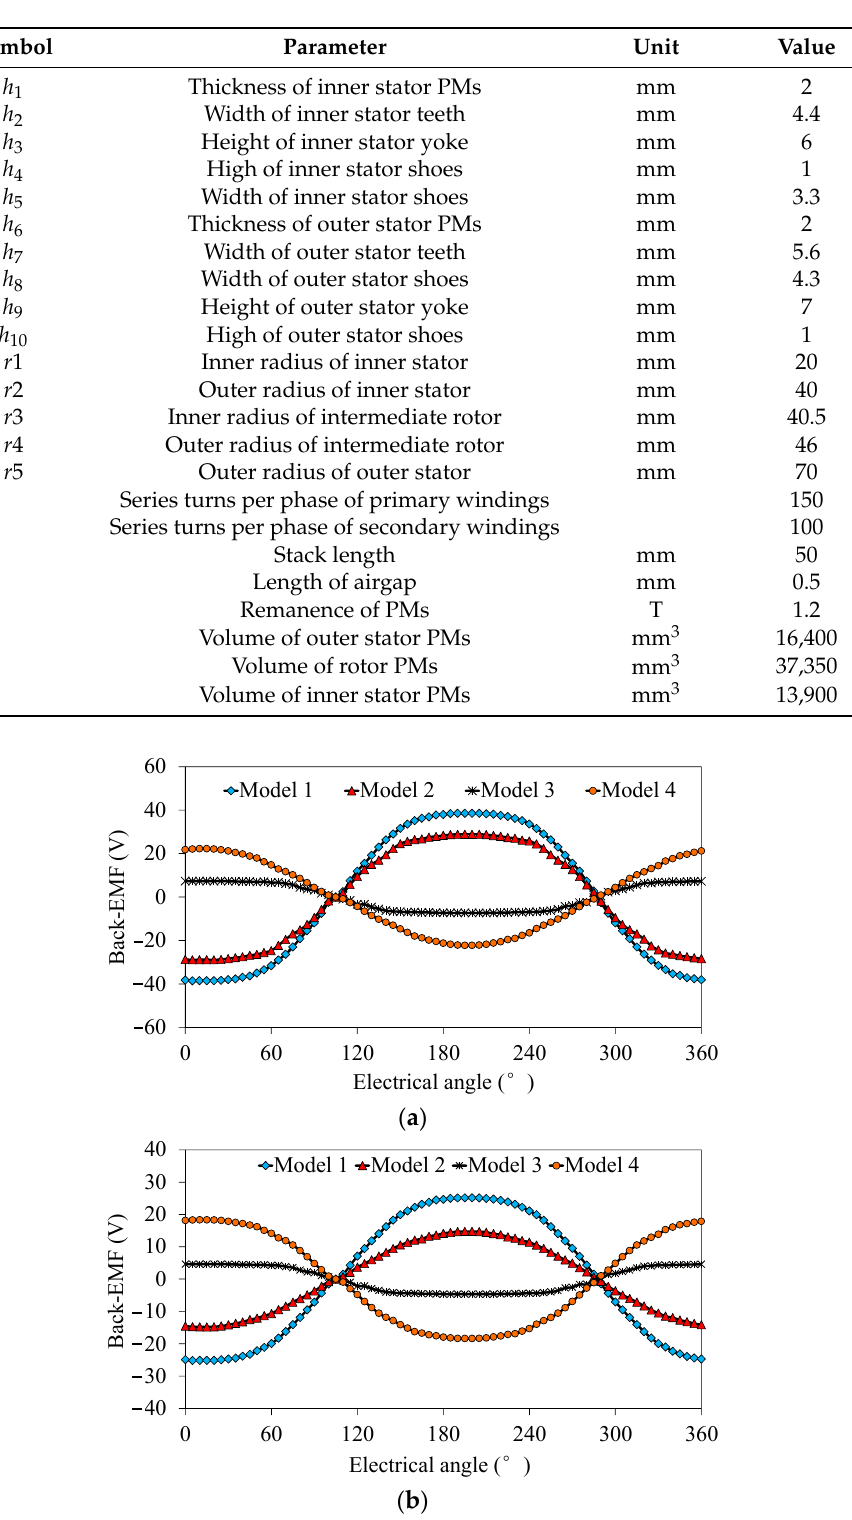
Table 3. Dimension parameters of TPMEV-DS Machine.